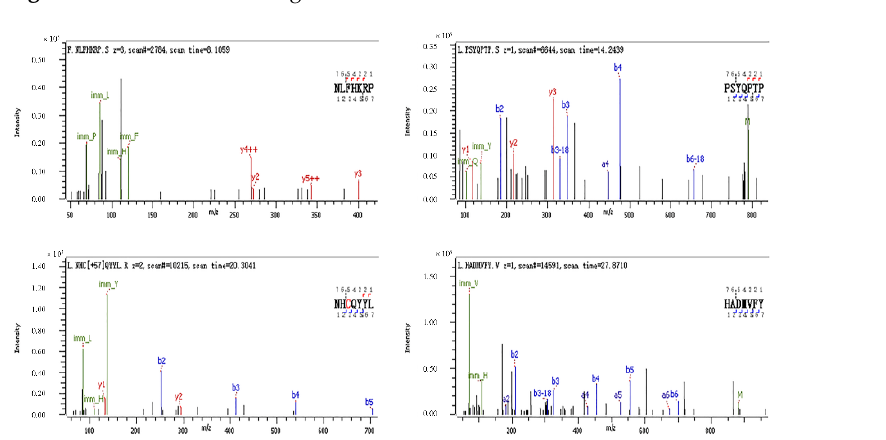
Figure 8. Total ion chromatogram.